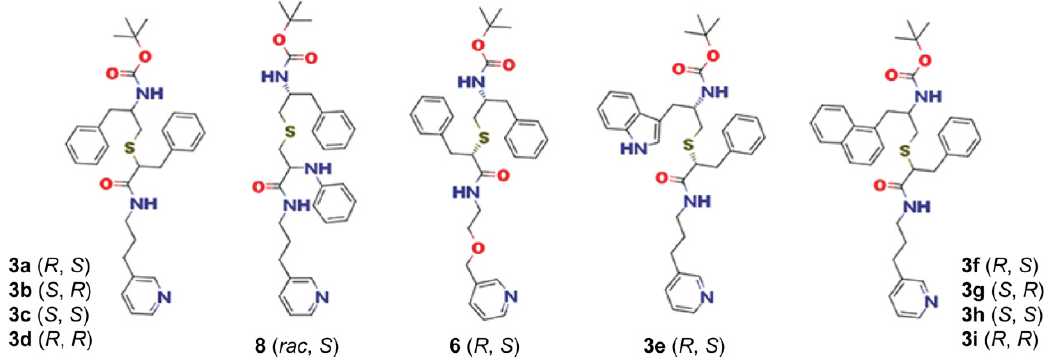
Figure 2. Chemical structures of series V analogues.